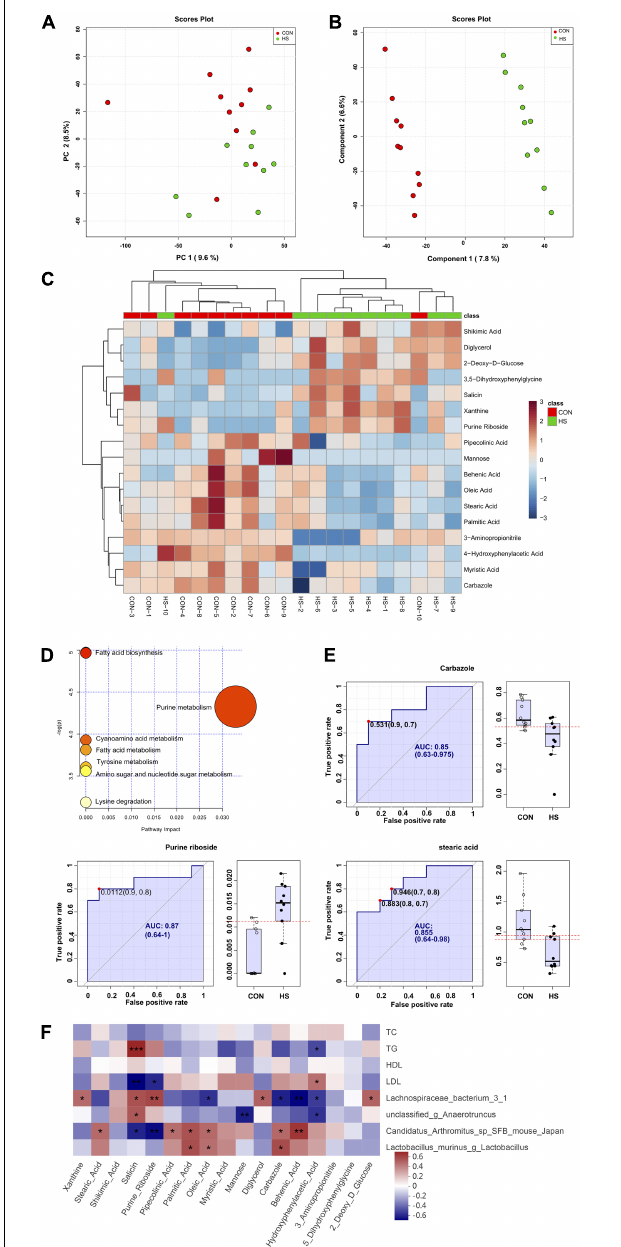
FIGURE 4 | Changes in cecal metabolite profile of mice shaped by heat stress. (A) PCA score plot. (B) OPLS-DA score plot. (C) heatmap tree show metabolites significantly different between groups and their phylogenic relationships. (D) Metabolic pathway enrichment analysis. (E) Biomarker analysis. (F) Correlations between serum indicators and gut microbiota, and cecum metabolic indicators mediated by heat stress. CON, control group; HS, heat stress group; OPLS-DA, Orthogonal partial least squares method-discriminant analysis. * P < 0.05, ** P < 0.01, *** P < 0.001.